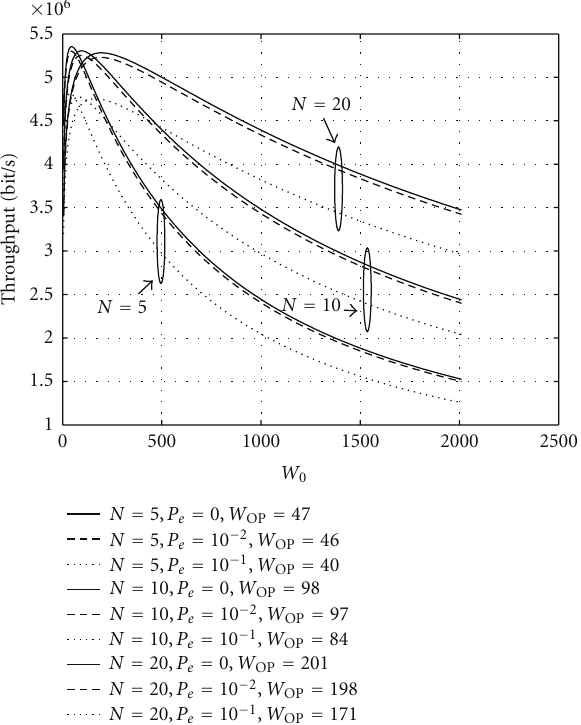
Figure 8: Saturation throughput as a function of the minimum contention window size W 0 , for data rate 11Mbps, three di ff erent values of P e and three values of the number of contending stations N as noticed in the legend. The other parameters are as follows: m = 5 and E [PL] = 1024 bytes. The optimal contention window size for each set of parameters is shown in the legend. Continuous curves represent the saturation throughput associated to the case P e = 0, the dashed curves refer to the case P e = 10 − 2 , and the dotted curves are related to the case P e = 10 − 1